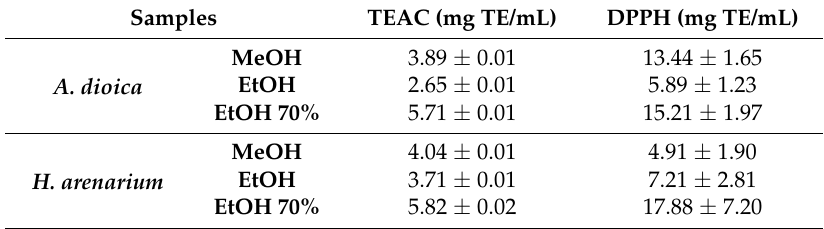
Table 5. Antioxidant capacity parameters obtained using several methods for studied samples.